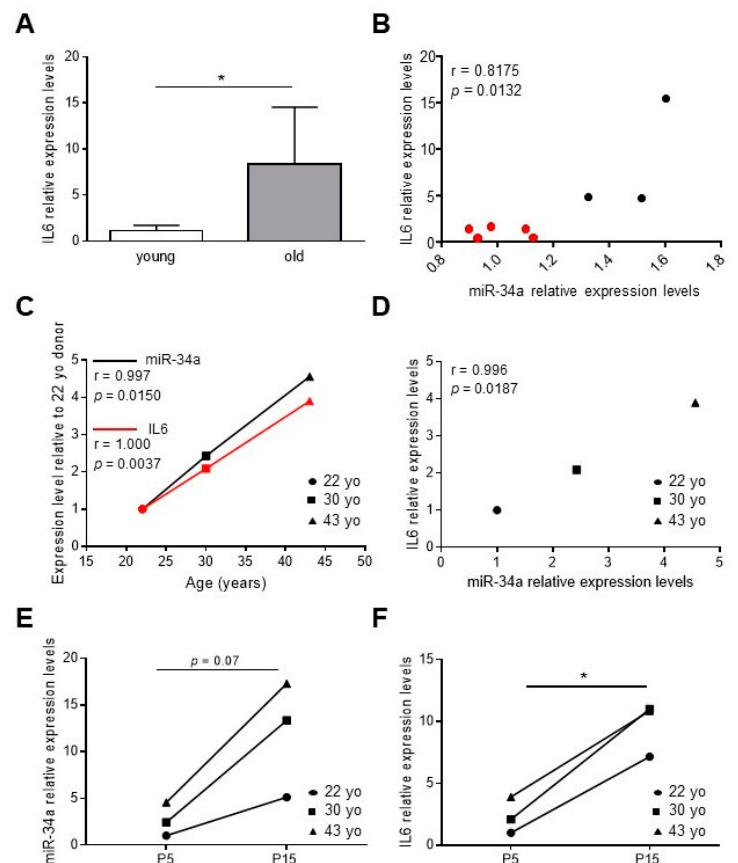
Figure 1. IL6 levels increase and correlate with miR-34a expression during vascular aging and human aortic smooth muscle cells (HASMCs) senescence. ( A ) IL6 expression in aortas of 2.5-month-old (young) and 21-month-old (old) mice analyzed by qRT-PCR and normalized to HPRT levels. Values represent the means ± SD. *, p < 0.05; Mann Whitney test; n = 5 young, 3 old mice. ( B ) Correlation analysis between miR-34a and IL6 levels in mice aortas. r = Pearson’s coe ffi cient; n = 5 young (red), 3 old (black) mice. ( C , D ) The miR-34a and IL6 mRNA expression in replicative young human aortic smooth muscle cells (HASMCs), isolated from different donors of indicated age (year-old; yo), was evaluated by qRT-PCR and normalized to corresponding U6 and GAPDH levels, respectively. Correlation analysis between ( C ) age (Age; years) and miR-34a or IL6 mRNA levels and ( D ) miR-34a and IL6 mRNA levels. r = Pearson’s coefficient; n = 3 donors. ( E , F ) miR-34a and IL6 mRNA expression in HASMCs isolated from donors of indicated age (year-old; yo) at young replicative (P5) and senescent (P15) passages evaluated by qRT-PCR and normalized to corresponding U6 and GAPDH levels, respectively. *, p <0.05; paired t test; n = 3 donors.